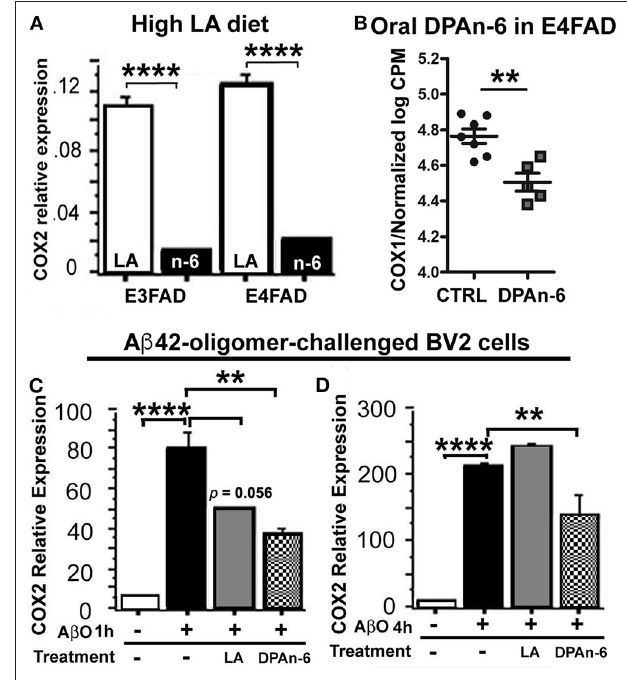
FIGURE 7 | Linoleic acid and DPAn-6 reduced cyclooxygenases (COXs) in EFAD mice and in A β 42 oligomers-stimulated microglial BV2 cells. (A) A high LA diet reduced mRNA expression of COX2 in both E3FAD and E4FAD mice compared to standard (ST) diet ( p < 0.0001) measured by RT-qPCR. (B) DPAn-6 reduced COX1 gene expression in RNA-Seq data ( p < 0.01) in DPAn-6 treatment of aged E4FAD. (C,D) DPA n-6 inhibited A β 42 oligomer-stimulated elevation of COX2 mRNA measured by RT-qPCR at 1h and 4h compared to the A β 42 oligomer-stimulated cells without DPAn-6 treatment ( p < 0.01, C,D ). LA showed a trend for short-term protective effects at 1h ( p = 0.056, C ) but not at 4h ( p > 0.05, D ). Data represent the mean ± SEM. Significance was analyzed by one-way ANOVA (A,C,D) and an unpaired, two-tailed Student’s t -test (B) , ** p < 0.01 and **** p < 0.0001.